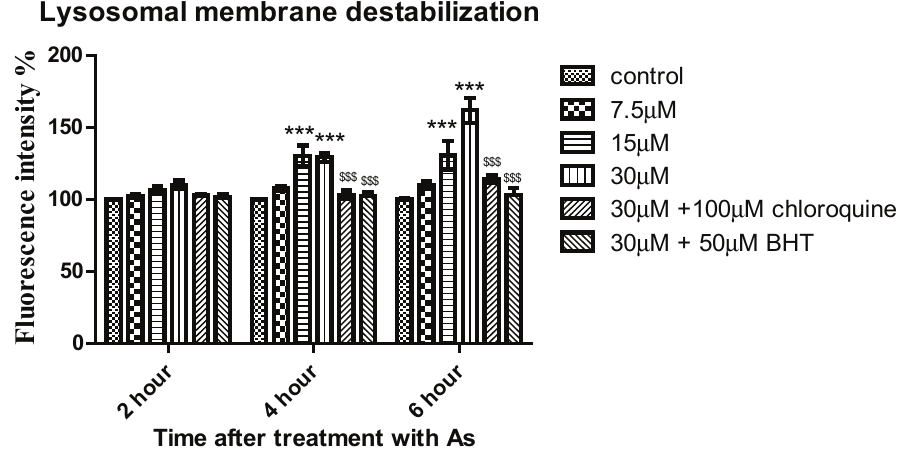
Figure 5: The influence of As on lysosomal membrane integrity. Two higher concentration of As (15 and 30 µM) significantly (P < 0.05) caused leakage of lysosomal membrane at 4 and 6 h. BHT and chloroquine prevented As-induced lysosomal membrane leakage. *** (P < 0.001): significant difference compared to the control group. $$$: significant difference with 30 µM